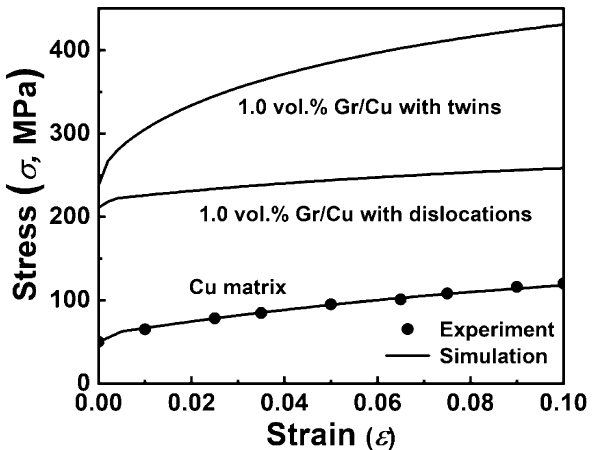
Figure 9. The mechanical properties of the Gr/Cu composites simulated by the VPSC-TMDT model. The results show that under the same conditions, the strengthening effect of the thermal mismatch twins is superior to that of dislocations.